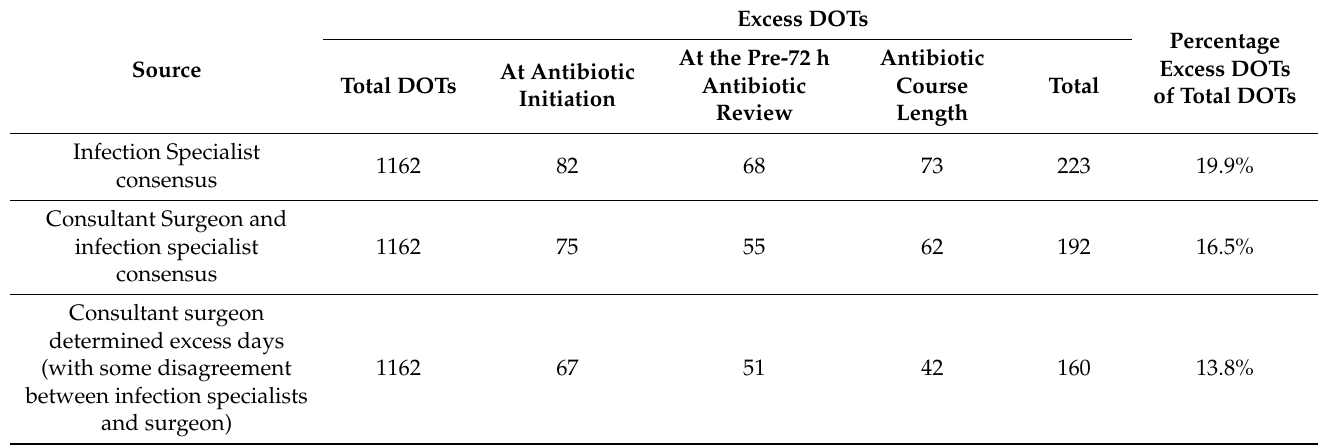
Table 2. Excess antibiotic days of therapy at each antibiotic decision time-points at each stage of specialist